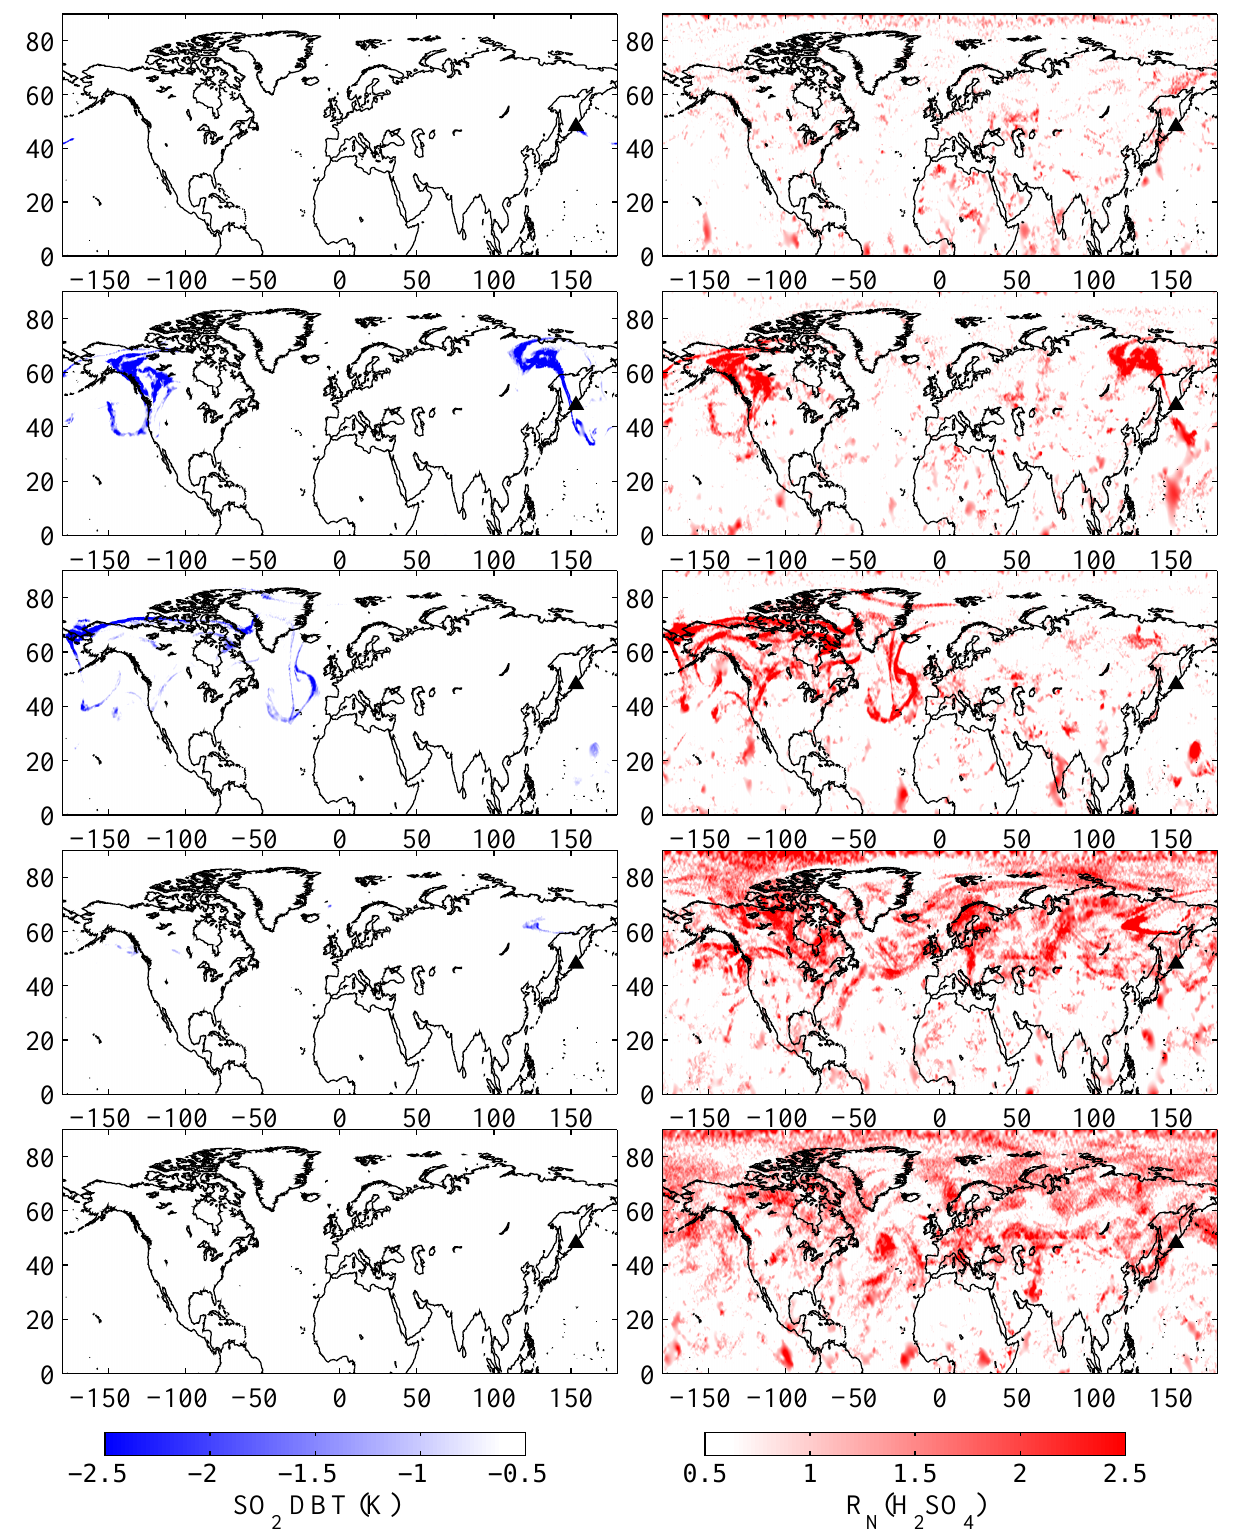
Fig. 1. View of the Northern Hemisphere on five different days (from top to bottom): 12 June (onset of the volcanic eruption of Sarychev), 19 June, 26 June, 12 July and 12 September 2009. On the left, the SO 2 BTD is shown and on the right R N ( H 2 SO 4 ).